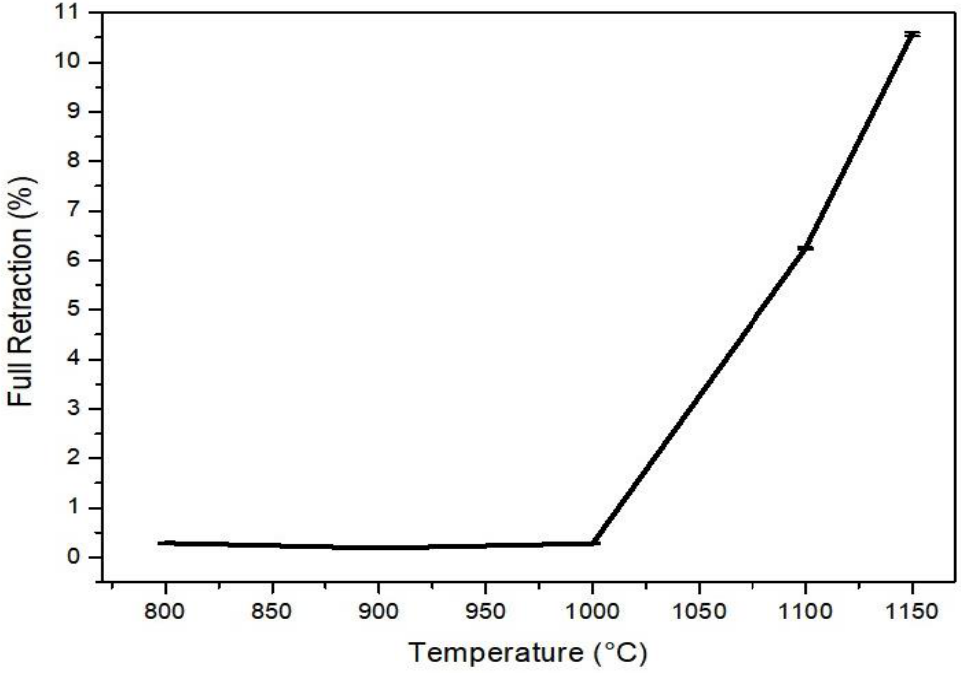
Figure 11. Result of the total linear shrinkage test.